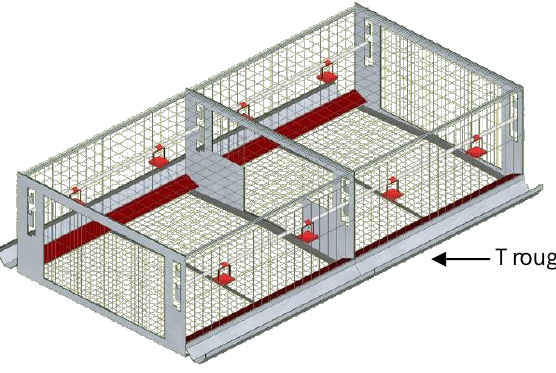
Figure 1. Schematic diagram of the natural mating colony cage.